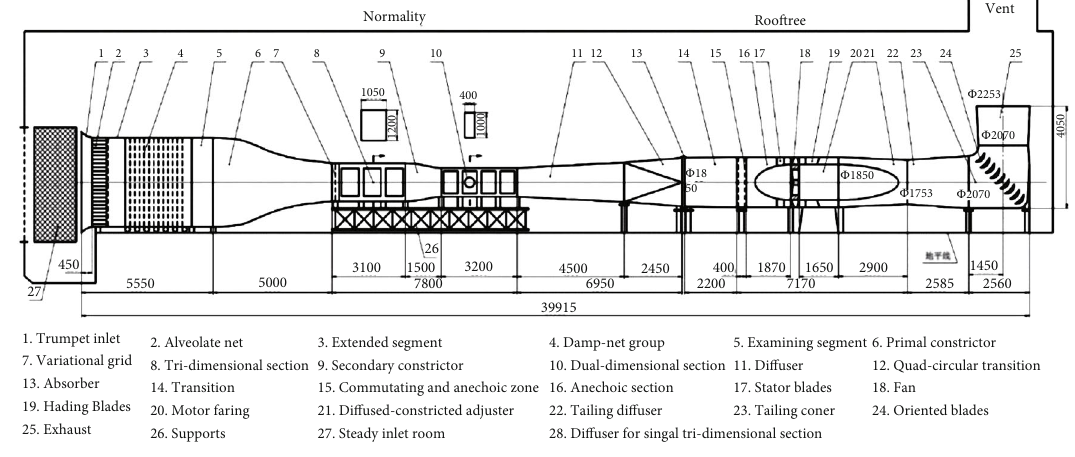
Figure 11: Layout of